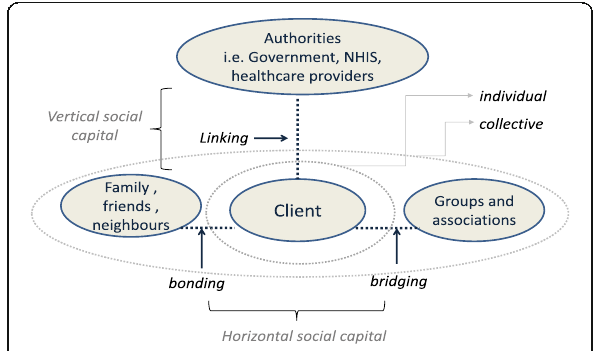
Fig. 1 Conceptual social capital framework (Fenenga et al.